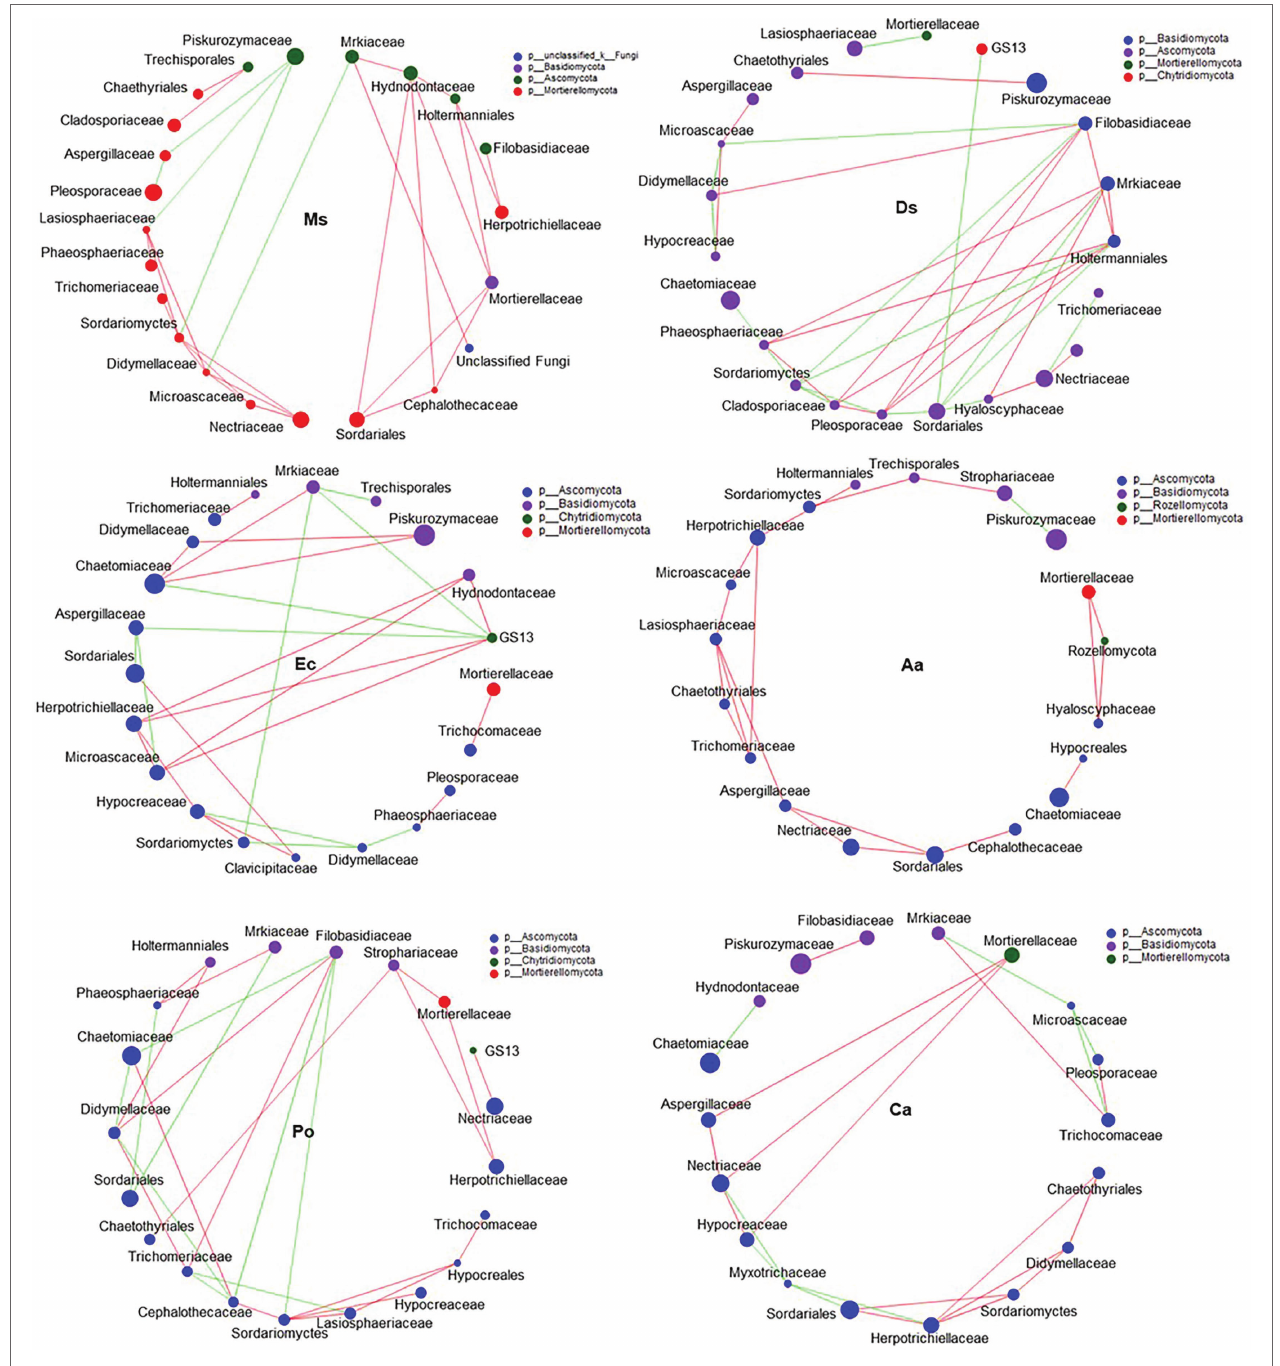
FIGURE 7 | Co-occurrence patterns of soil fungi in root-associated alfalfa and weed soil. Positive links between nodes are shown in red and negative links are shown in green (coefficient > 0.5 and p <